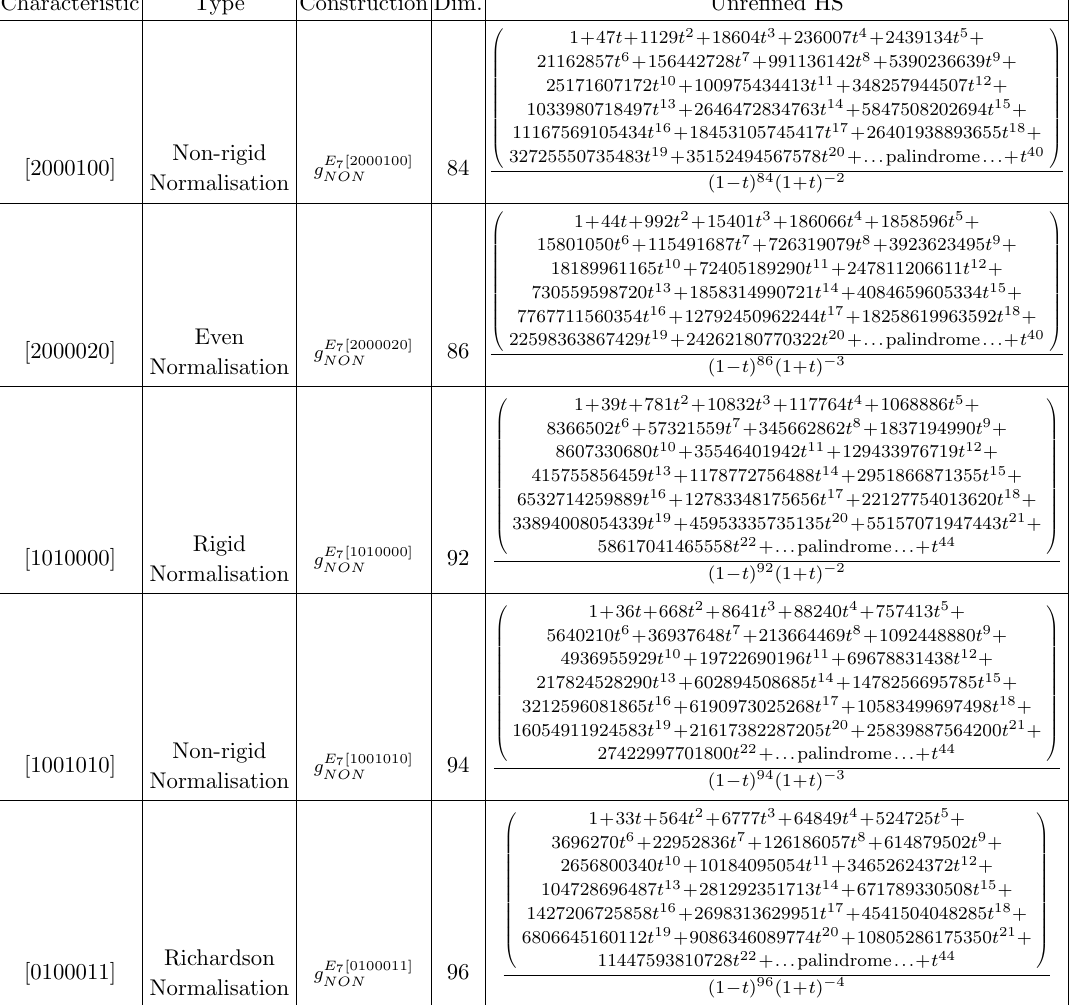
Table 24 . E 7 nilpotent orbit normalisations and Hilbert series